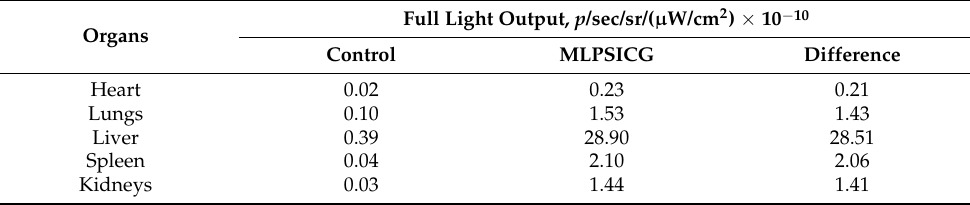
Table 2. Numerical characteristics of the distribution of fluorescence in